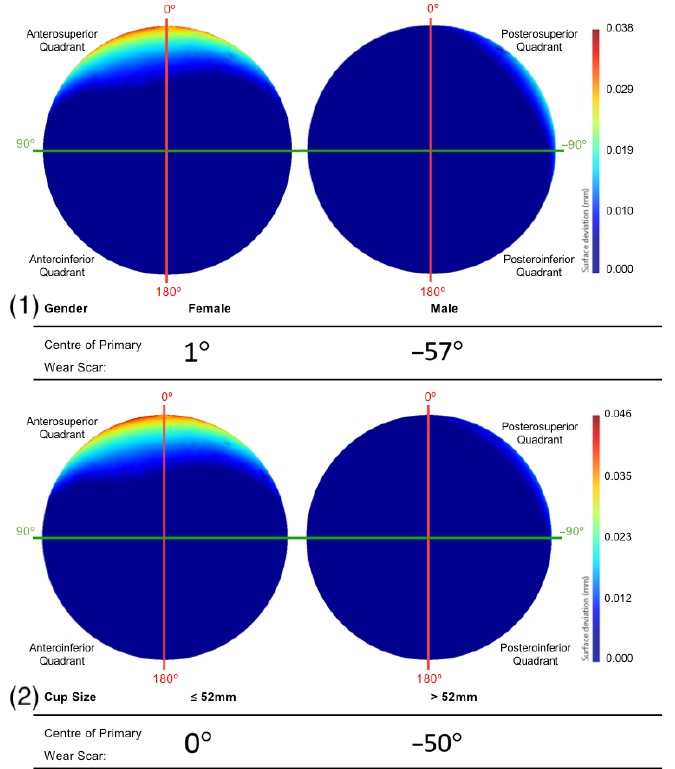
Figure 10. The mean surfaces generated following the subdivision of the acetabular surface, based on their (1) gender and (2) component size. This is presented as deviation maps of their comparison with the as-manufactured reference surface (mm).